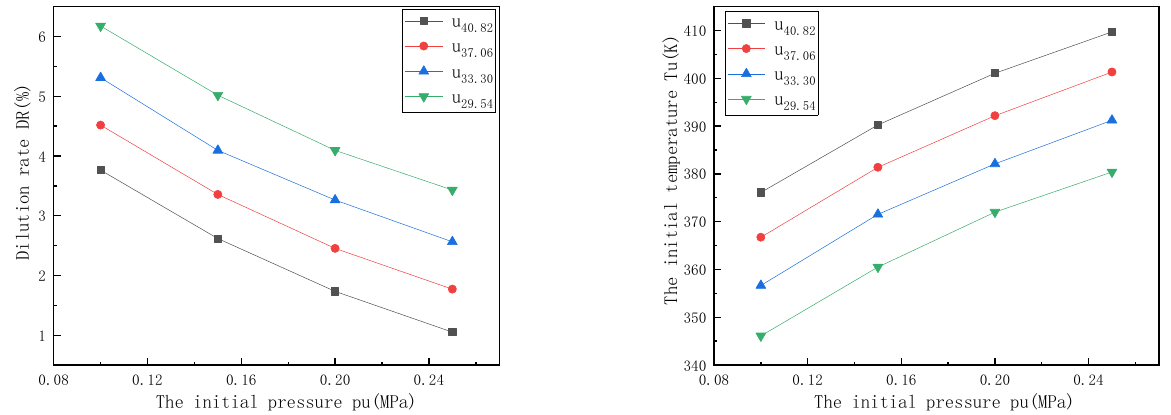
Figure 12. The rate of change R of the u L corresponding to the Pu. Figure 13 shows the equivalent distribution pattern of u L under the coupling effect of Tu and DR when Φ is 1.0 and when the range of the initial temperature is 348–423 K. The figure indicates that u L gradually decreases from the low-pressure and low-dilution rate area to the high-pressure and high-dilution rate area. When the initial temperatures are 348 K, 373 K, 398 K and 423 K, the ranges of u L are 15.50–46.80 cm/s, 17.80–52.60 cm/s, 20.2–58.8 cm/s and 22.8–65.4 cm/s. With the increase in initial temperature, the variations in u L are 31.3 cm/s, 34.8 cm/s, 38.6 cm/s and 42.6 cm/s, respectively, exhibiting a gradually increasing trend. The larger the initial temperature, the greater the variation in u L as well as the rate of change R in u L . In addition, from the high-pressure and high-dilution rate area to the low-pressure and low-dilution rate area, u L shows a clear upward trend, and as Pu and DR decrease, u L changes faster, that is, a larger rate of change in u L in the low- pressure and low-dilution rate area.